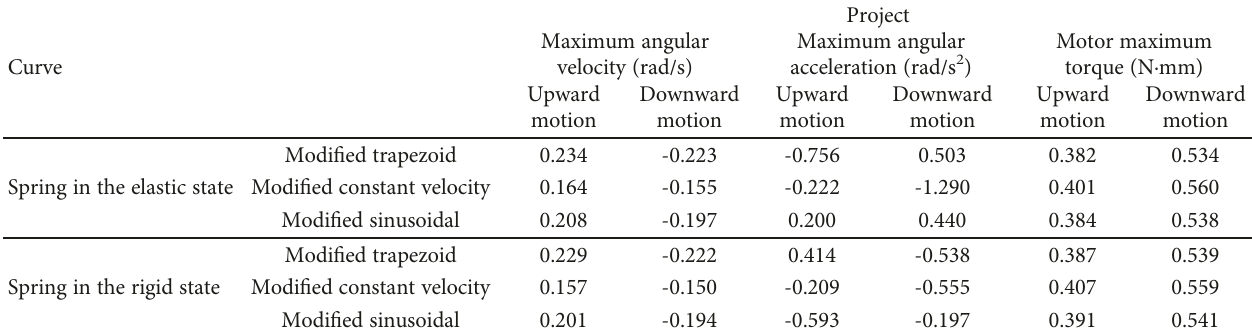
Table 3: Analysis results of maximum angular speed and acceleration of the platform and maximum motor torque.